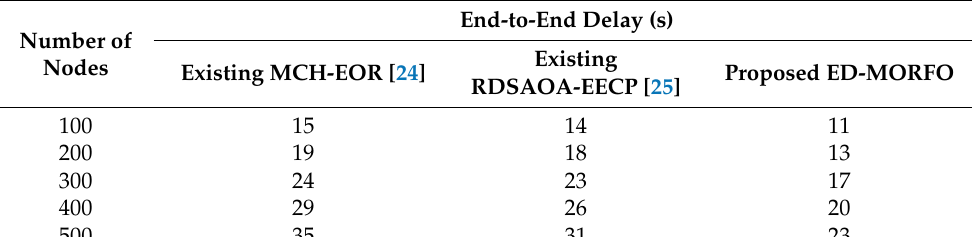
Table 7. Performances of routing overhead.